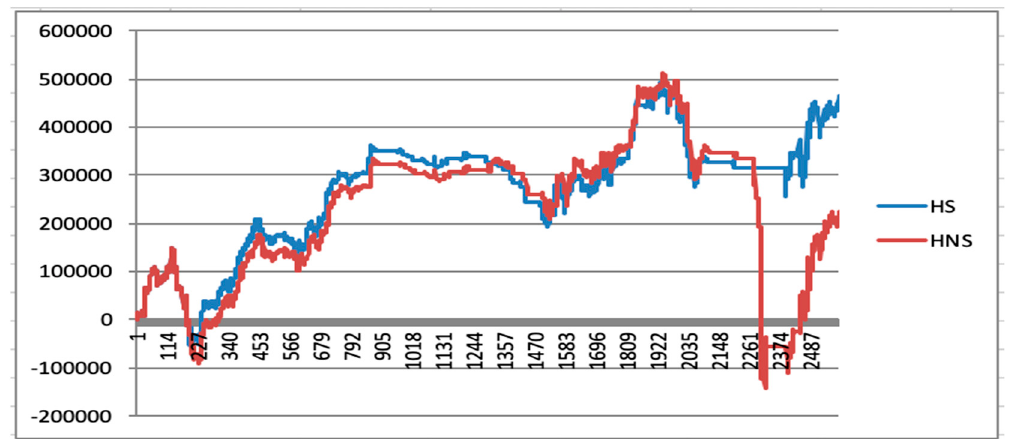
Figure 33. Comparison of the signal strategy with or without a line chart (25% after forecasting).